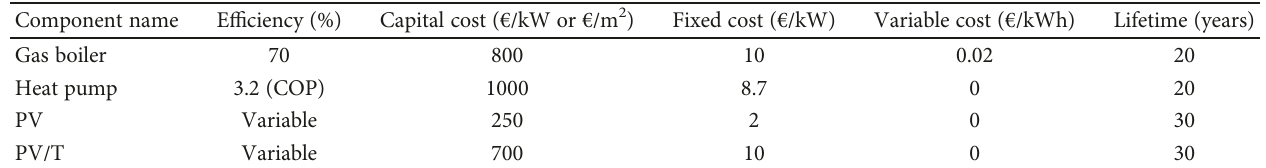
Table 2: EH system component parameters.